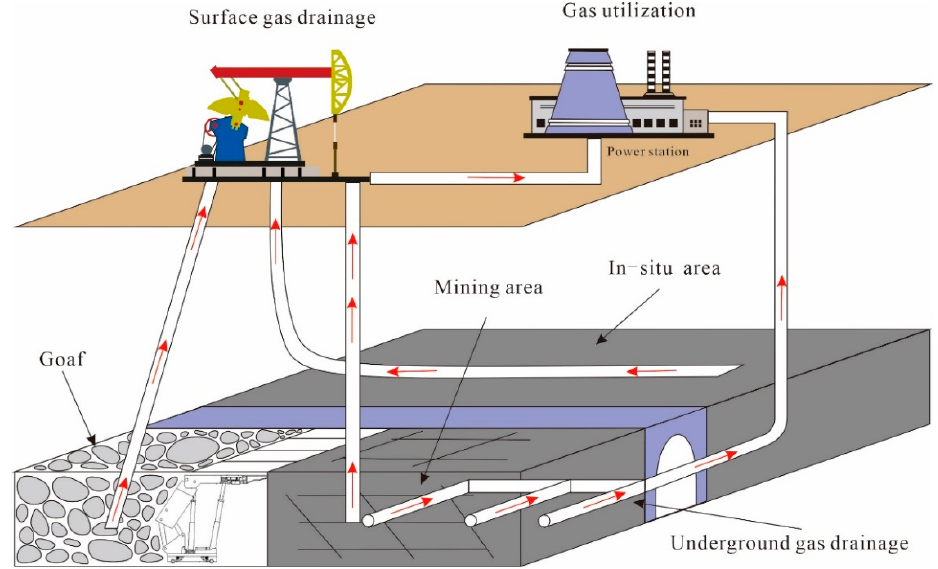
Figure 11. Integrated development model of the surface–underground CBM three-dimensional drainage in coal mine area.